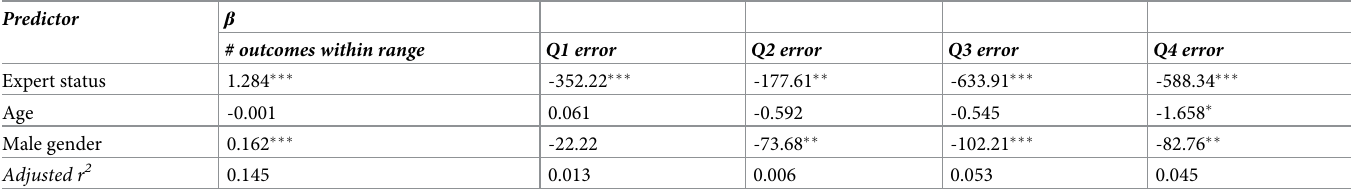
Table 4. Regressions of calibration and accuracy on gender, age, and expert/nonexpert status. Predictor β # outcomes within range Q1